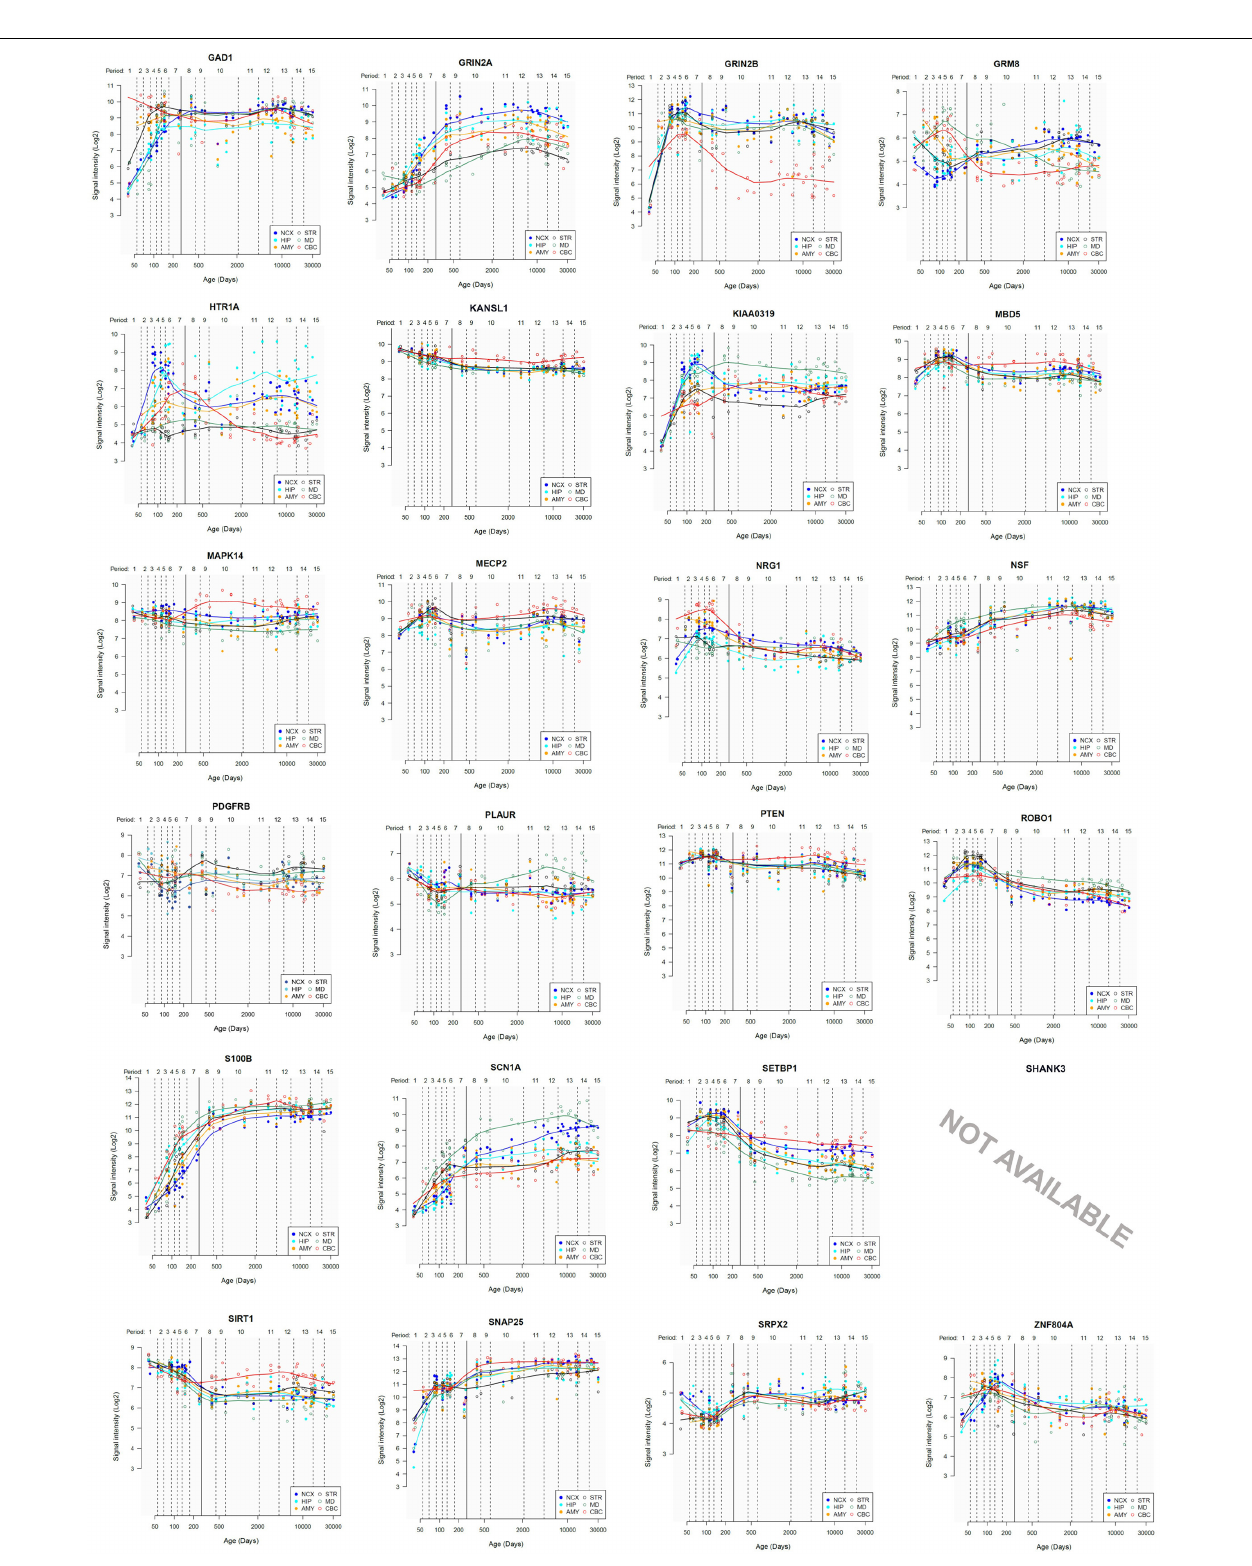
FIGURE 4 | Individual brain expression profiles across development of the set of genes considered in this study (25–48).